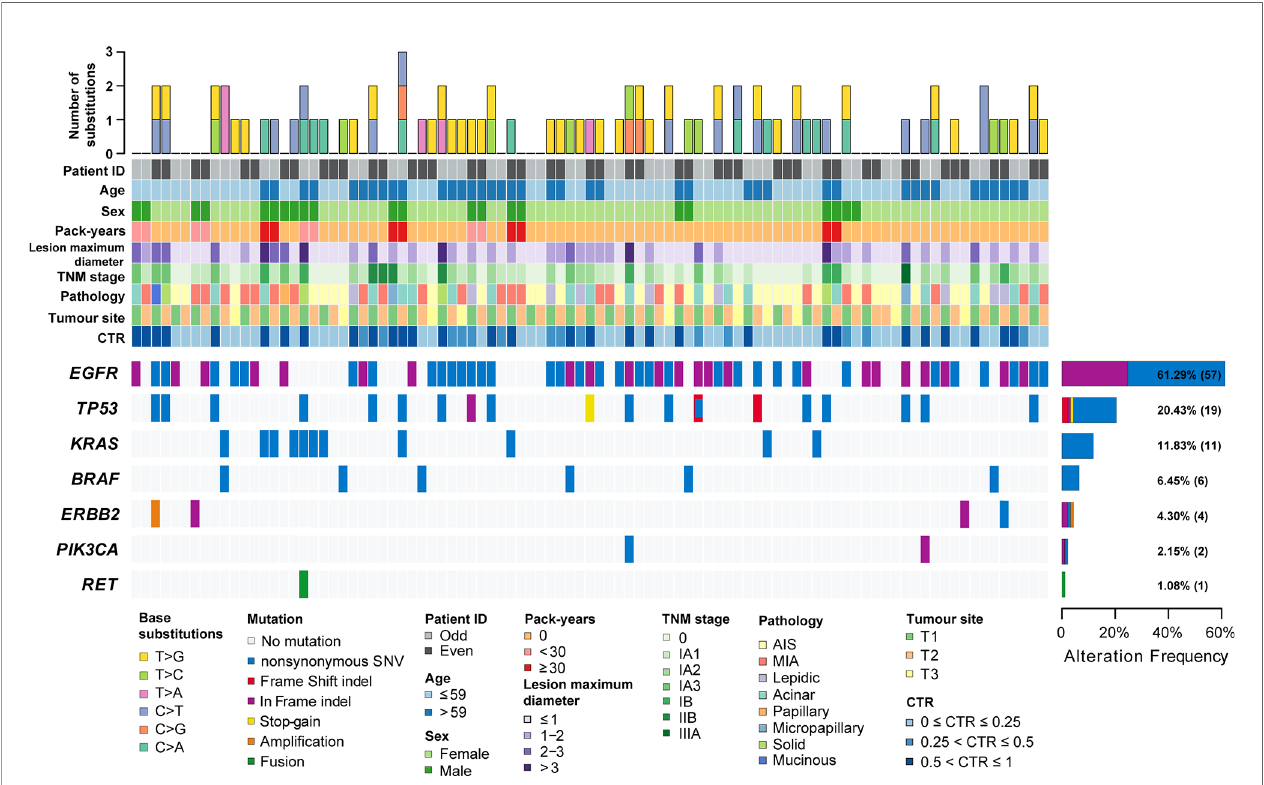
FIGURE 1 | The clinicopathological and imaging features and mutation landscape of 93 synchronous multiple primary lung adenocarcinomas. The number and types of base substitutions in each tumour are shown in the upper panel. Clinical features are annotated in the middle panel. The heat map below clearly displays the number and type of somatic mutated genes in each tumour, including nonsynonymous SNVs (single nucleotide variants), frame shift indels, in-frame indels, stop-gain mutations, ampli fi cation and